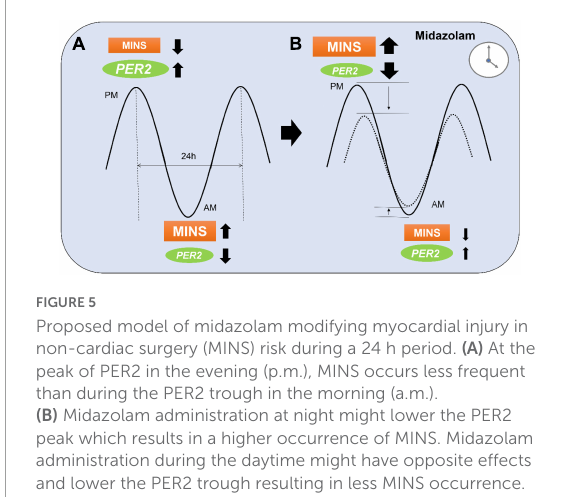
FIGURE5 Proposed model of midazolam modifying myocardial injury in non-cardiac surgery (MINS) risk during a 24 h period. (A) At the peak of PER2 in the evening (p.m.), MINS occurs less frequent than during the PER2 trough in the morning (a.m.). (B) Midazolam administration at night might lower the